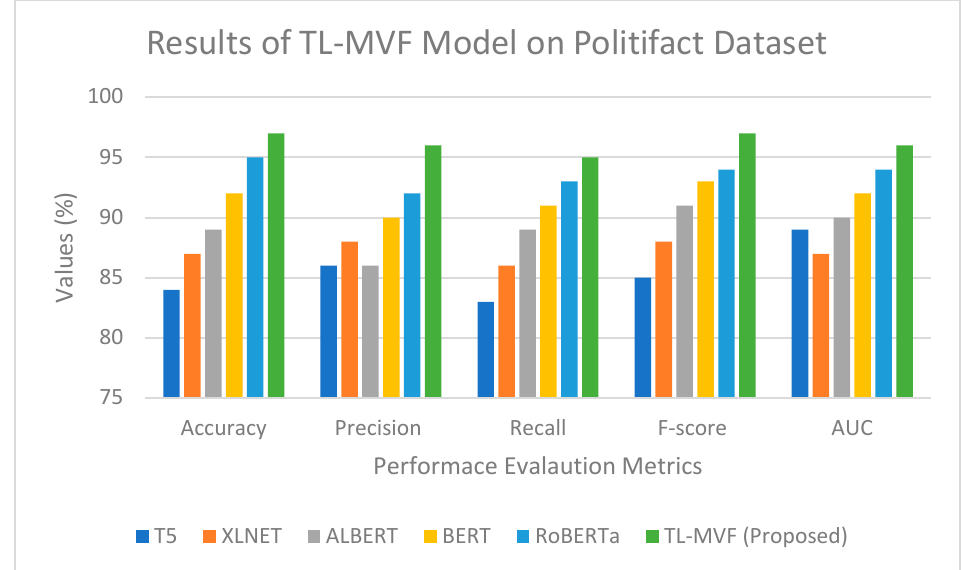
Figure 9. Comparative result analysis of the TL-MVF with existing benchmarked models on the PolitiFact dataset.